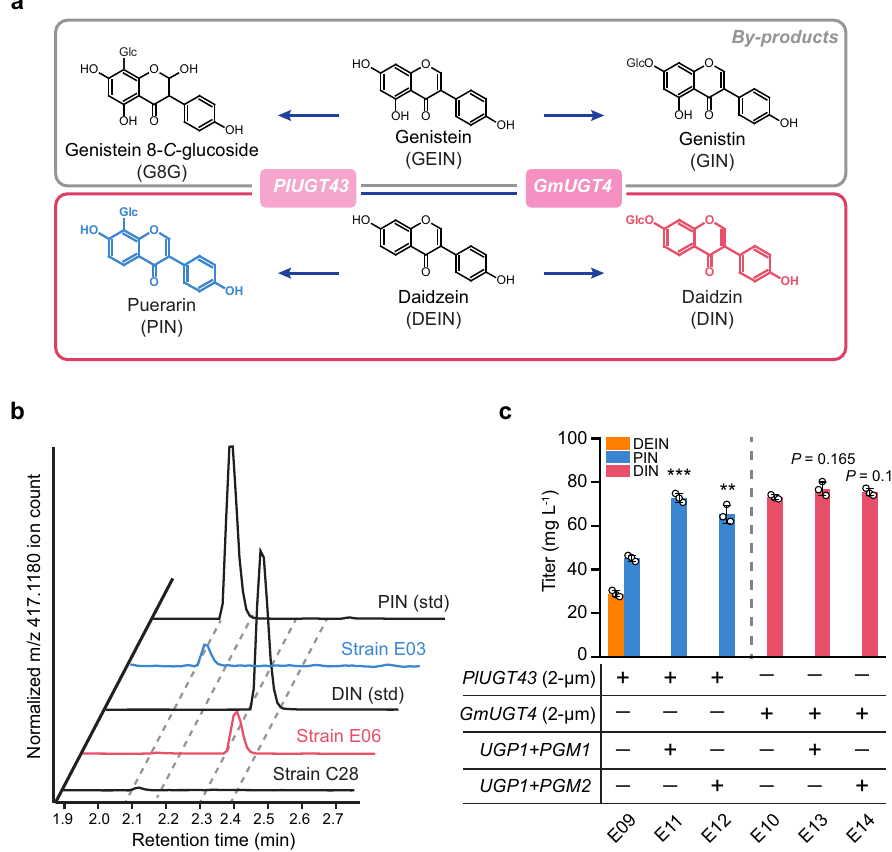
Fig. 7 Production of DEIN-derived glucosides. a Schematic view of the engineered metabolic pathways for the biosynthesis of glucosides PIN and DIN (pink box), and relevant byproducts (gray box). See Fig. 1 legend for gene details. b Characterization of metabolic enzymes responsible for glucoside biosynthesis. Three copies of PlUGT43 and GmUGT4 under the control of constitutive promoters were integrated into the DEIN producer C28, resulting in strains E03 and E06, respectively. Cells were grown in a de fi ned minimal medium with 30 g L − 1 glucose as the sole carbon source, and cultures were sampled after 72 h of growth for LC-MS analysis. c Production pro fi les of PIN and DIN in DEIN hyper-producing strain I34 background with or without increased UDP-glucose supply. Combined overexpression of genes PGM1 / 2 with UPG1 was implemented to enhance the generation of glycosyl group donor UDP-glucose. See Fig. 1 legend for gene details. Cells were grown in a de fi ned minimal medium with six tablets of FB as the sole carbon source and 10 g L − 1 galactose as the inducer. Cultures were sampled after 90 h of growth for metabolite detection. Statistical analysis was performed by using Student ’ s t test (two-tailed; two-sample unequal variance; * p < 0.05, ** p < 0.01, *** p < 0.001). All data represent the mean of n = 3 biologically independent samples and error bars show standard deviation. The source data underlying fi gure c are provided in a Source Data fi